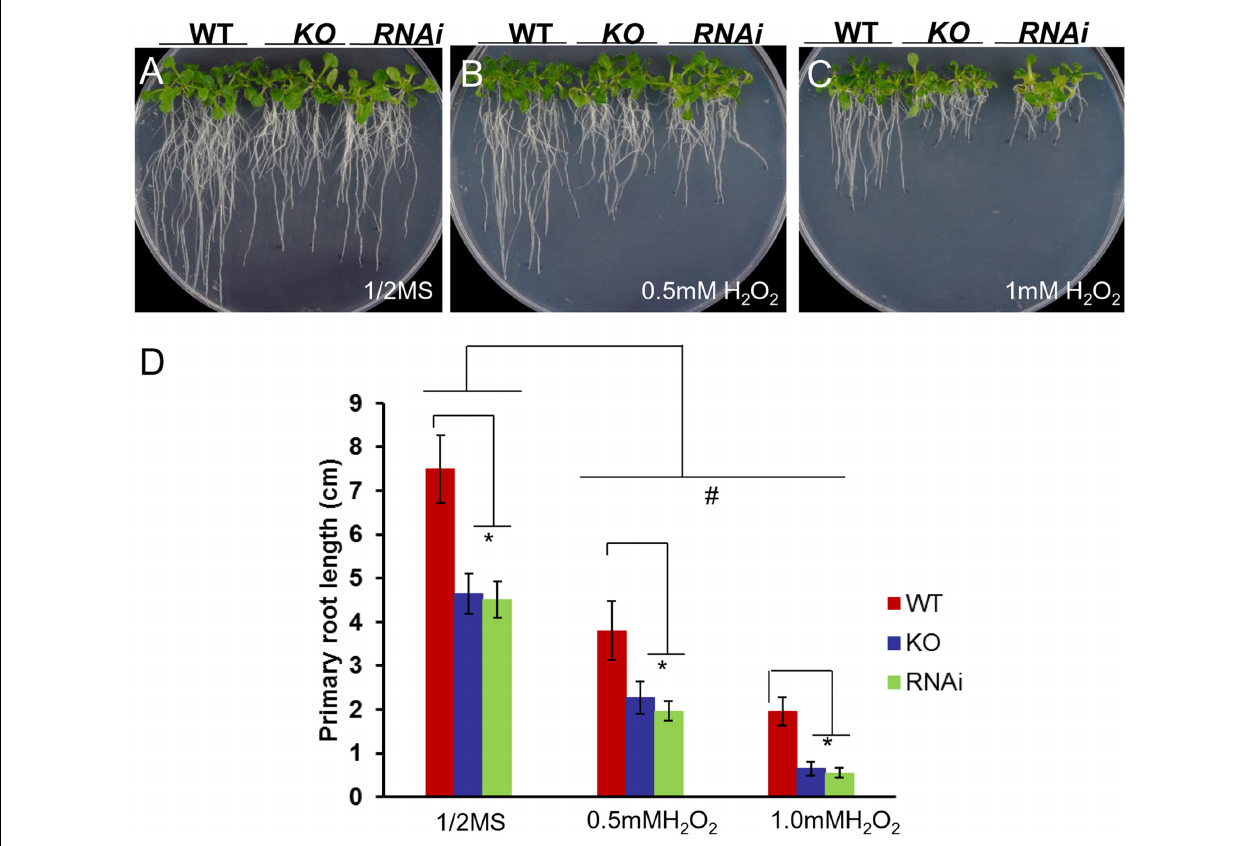
FIGURE 4 | atgrxs17 KO and AtGRXS17 RNAi seedlings are sensitive to oxidative stress. Wild type, atgrxs17 KO, and AtGRXS17 RNAi seeds were germinated and vertically grown on 1 / 2 MS medium (A) and the same medium supplemented with 0.5 mM (B) and 1 mM (C) H 2 O 2 for 10 days. (D) The length of primary roots was recorded. Statistical analysis using a two-way ANOVA. n ≥ 18. ∗ p < 0.05, significance between WT controls and atgrxs17 mutants; # p < 0.05, significance between 1 / 2 MS medium and H 2 O 2